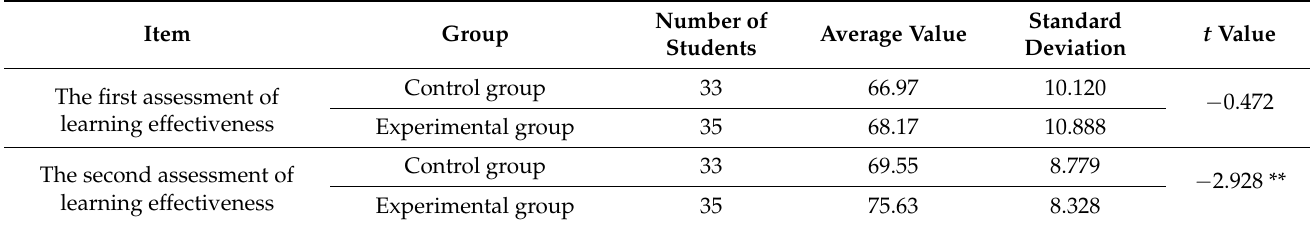
Table 5. Recapitulation sheet of basic electricity practical learning effectiveness scores.